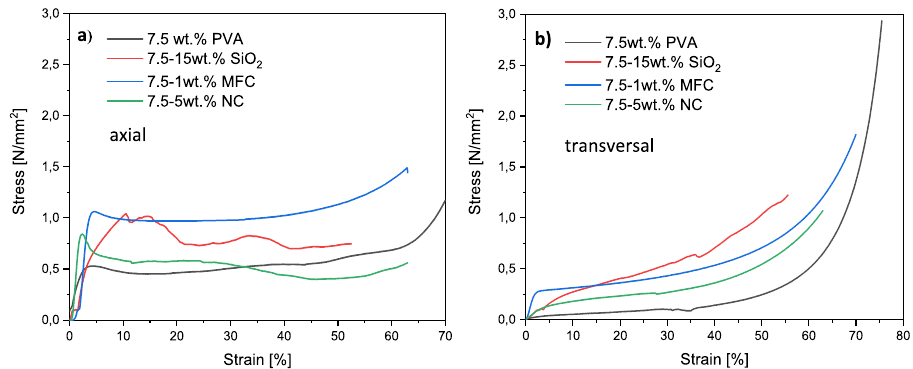
Figure 4. Stress–strain-curves in axial ( a ) and transversal ( b ) directions for the composites with 7.5 wt.% PVA. Pure PVA scaffolds (black), PVA/SiO